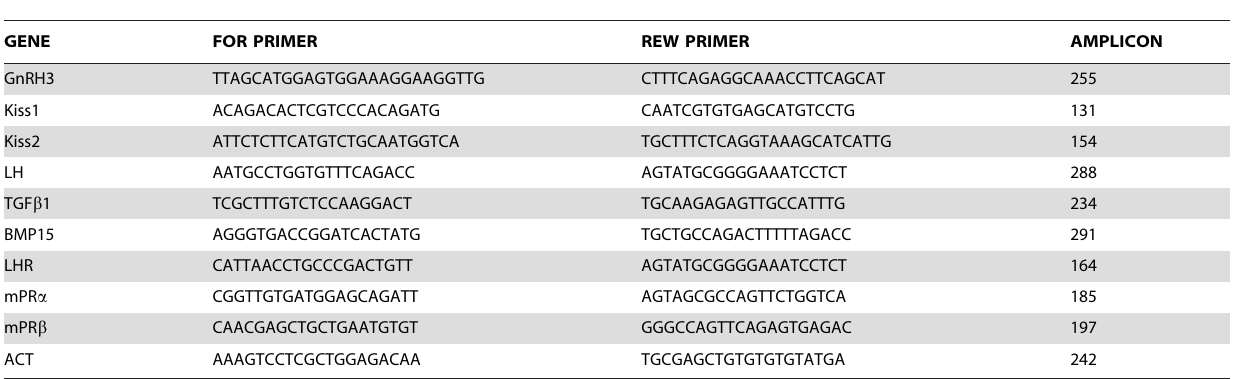
Table 1. List of primers used for real time PCR